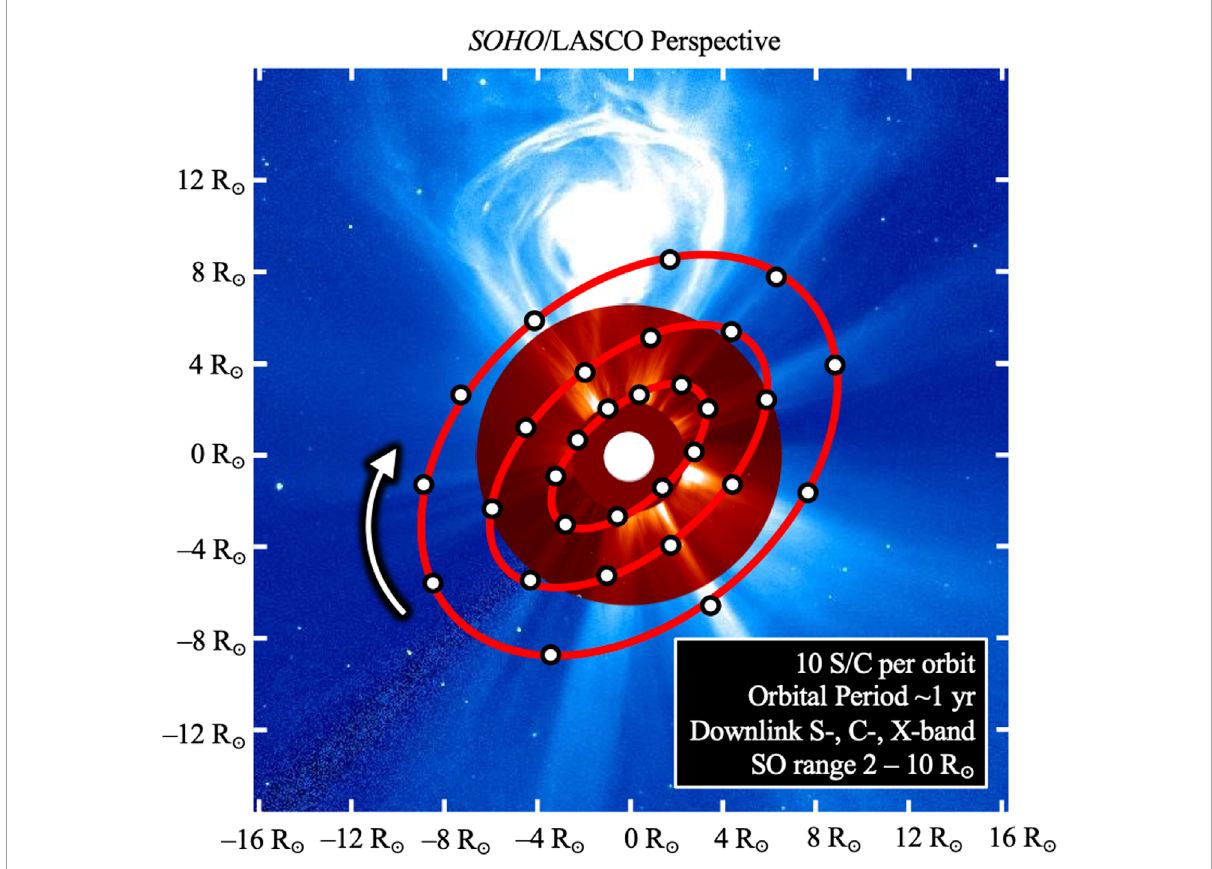
FIGURE 1 Illustration of potential spacecraft (S/C) positions for the Trans-Coronal Radio Array Fleet (T-CRAF) mission concept. There are ten spacecraft (white plotted points) per orbit (red). The inner, middle, and outer orbits have major axis lengths of ≈ 8 R ⊙ , ≈ 14 R ⊙ , and ≈ 20 R ⊙ , respectively, and minor axis lengths of ≈ 4 R ⊙ , ≈ 8 R ⊙ , and ≈ 14 R ⊙ , respectively. The arrow shows the direction of orbit. The white circle in the image center is the photosphere. The background shows a CME on 2000 February 27 as observed with the C2 (red) and C3 (blue) coronagraphs on board SOHO